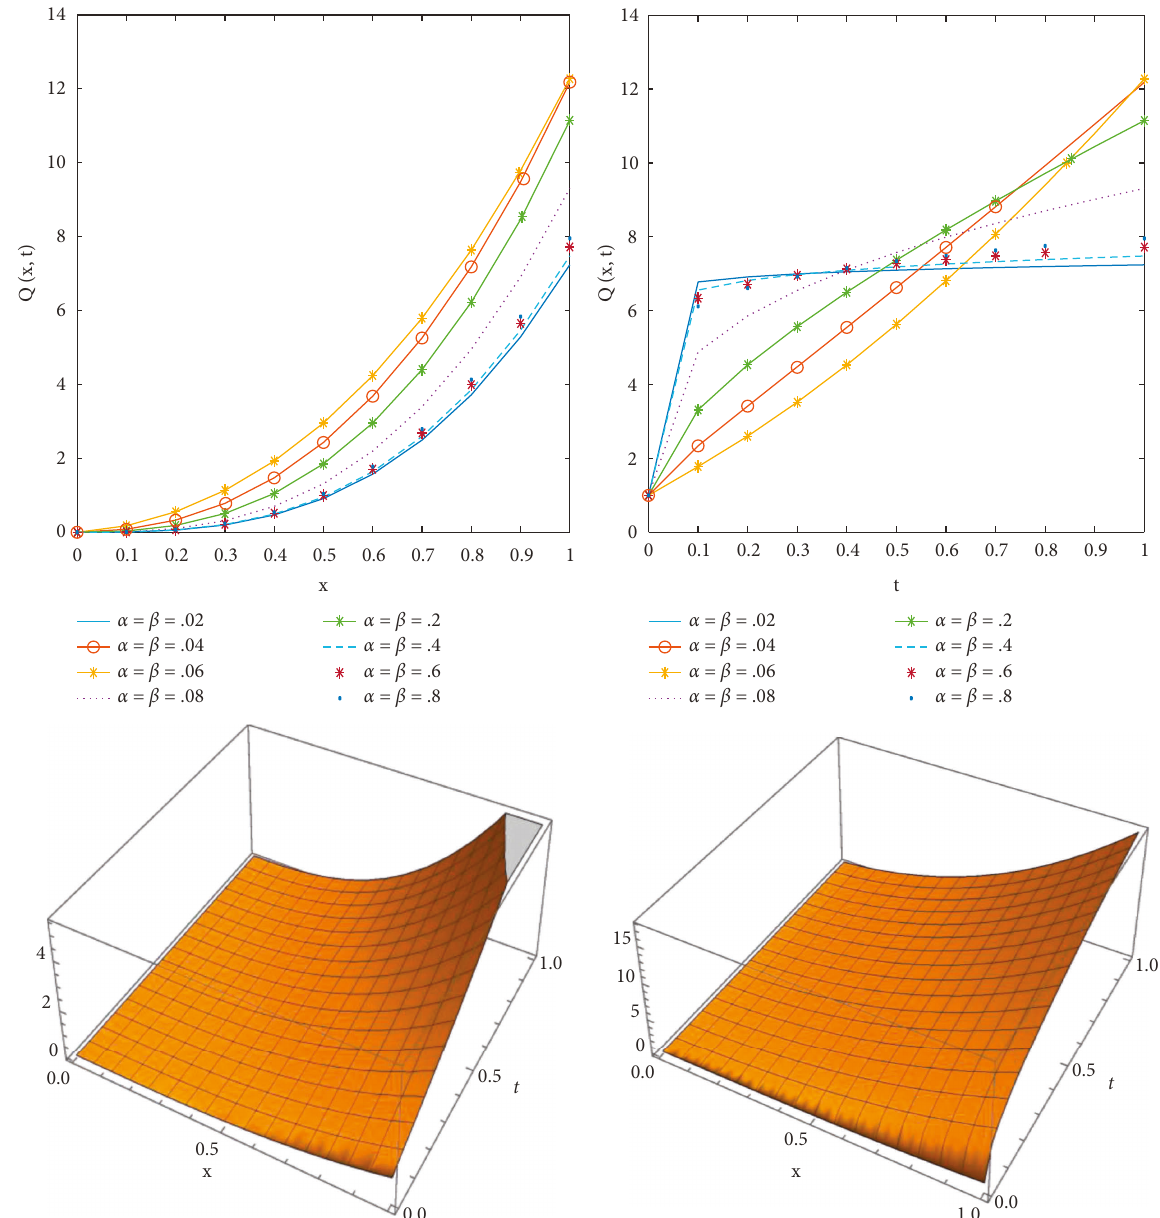
Figure 1: Comparison of the solution at various values of alpha and